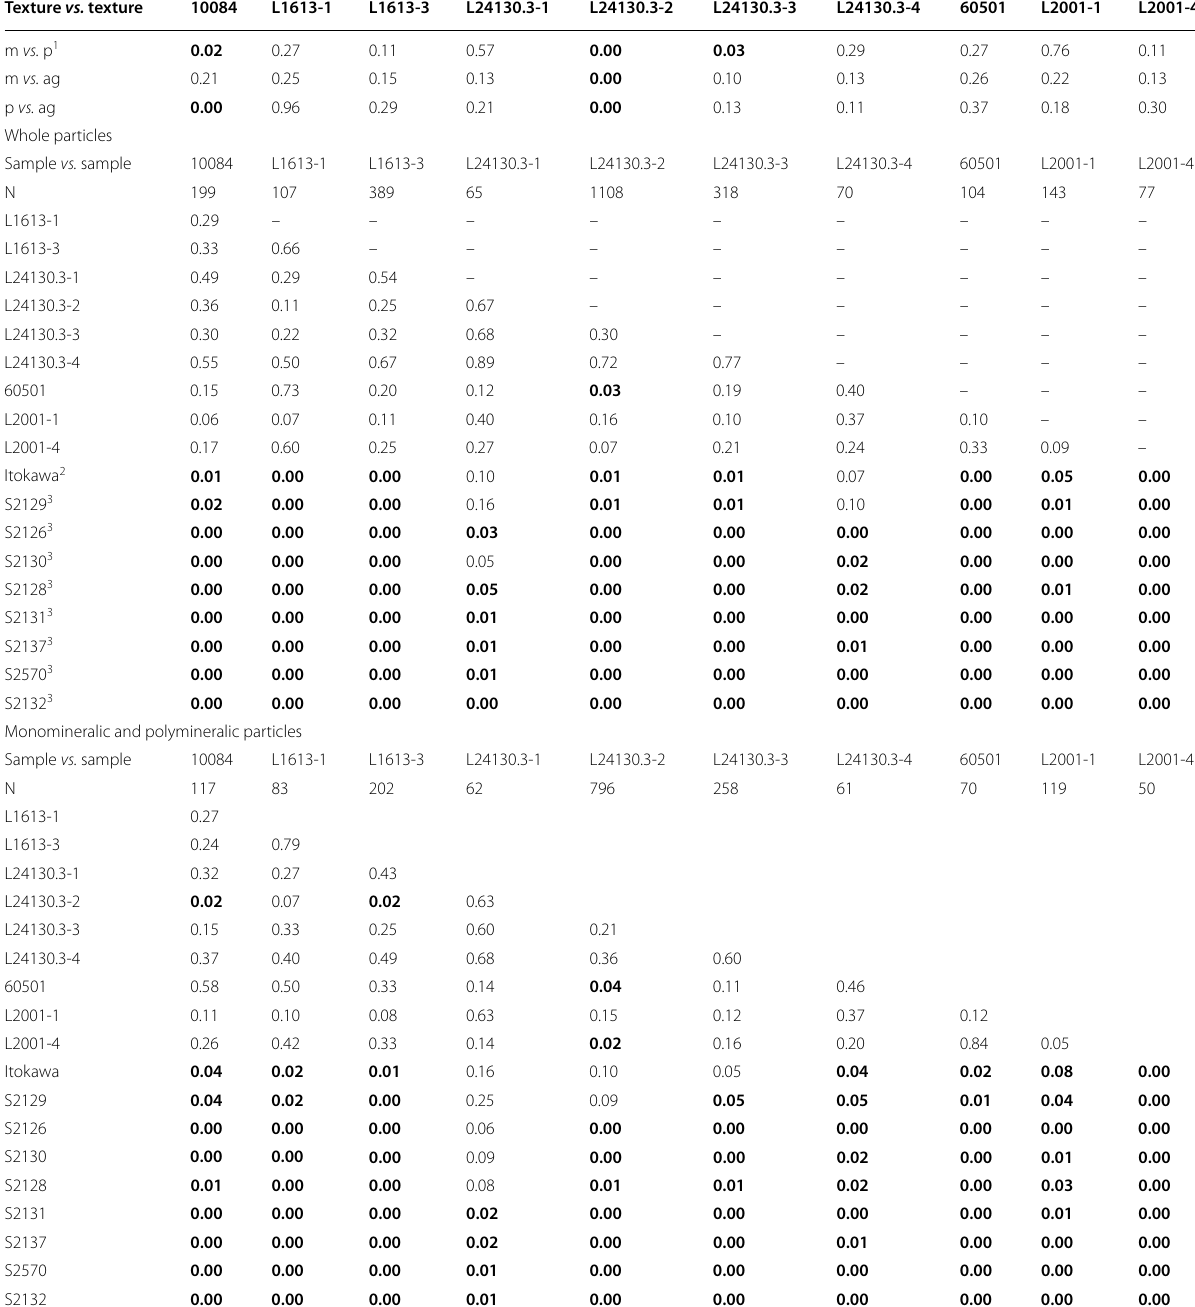
Table 2 Probabilities of Kolmogorov–Smirnov test for particle shape distributions among textural types and lunar vs. Itokawa and impact experiment